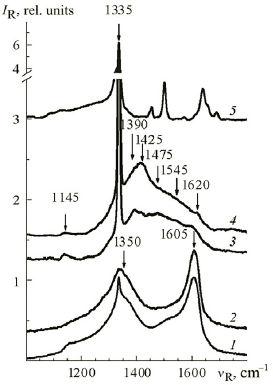
Figure 6. Raman spectra of single-layer nano- and microcrystalline diamond coatings were measured in the entire region (1, 3) and the region of maximum wear (2, 4) after tribological tests with a Si3 N4 counter-ball. Spectrum 5 is measured in a natural diamond crystal implanted with nickel ions [105]. The spectra are shifted vertically relative to each other for clarity [20]. In the RAMAN spectra of microcrystalline diamond (Figure 6, spectrum 3), the dia- mond peak with a maximum at ΔνR = 1335 cm −1 is dominant. In addition to the low-in- tensity bands, with maxima at 1155, 1350, and 1475 cm −1 , it is observed in the spectrum of nanocrystalline DC that relatively narrow bands with maxima around 1390, 1425 and 1620 cm –1 appear in the microcrystalline coating (spectra 3 and 4). The relative intensity of these bands varies along the DC surface. It was probably determined by the morphological fea-